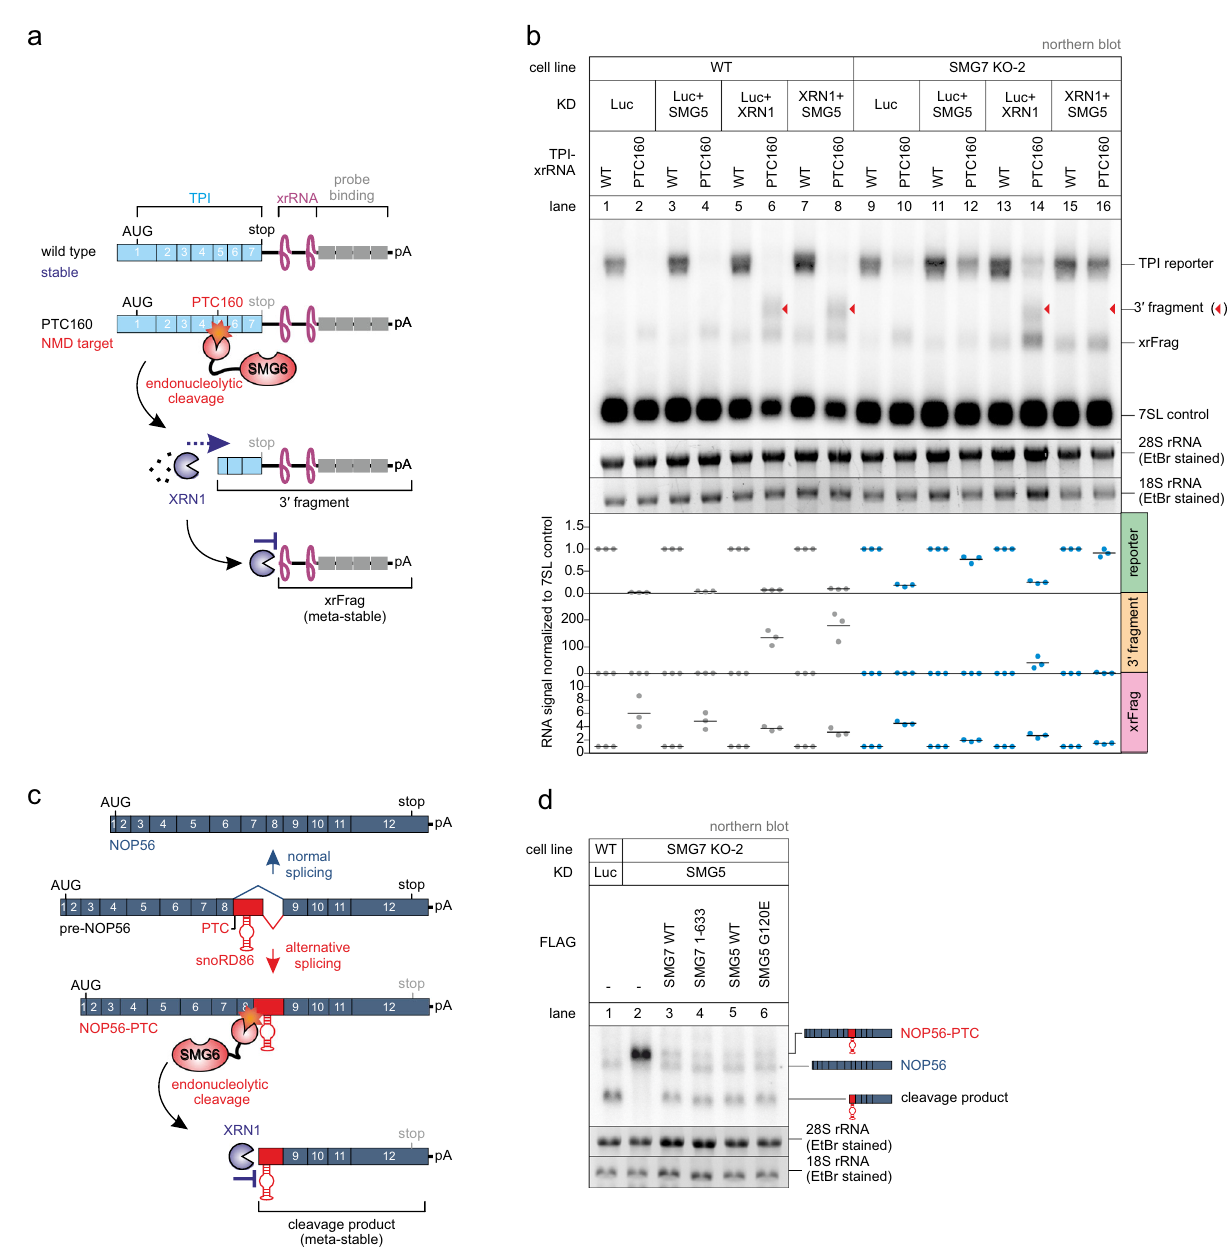
Fig. 5 SMG6 endonucleolytic cleavage is inactivated in SMG5-SMG7 depleted cells. a Schematic overview of the triosephosphate isomerase (TPI) reporter constructs and their functional elements. The PTC160-containing reporter is subjected to SMG6-mediated endonucleolytic cleavage during NMD. The resulting decay intermediate (3 ′ fragment) is rapidly degraded by XRN1, until the presence of an xrRNA blocks the processivity of XRN1, ultimately resulting in the accumulation of meta-stable xrFrag molecules. b Northern blot analysis of TPI reporter, 3 ′ fragments (indicated with red triangles), xrFrag, and 7SL endogenous control. Ethidium bromide-stained 28S and 18S rRNAs are shown as additional controls. Quanti fi cation results (normalized to 7SL control) are shown as data points and mean ( n = 3 biologically independent samples). c Schematic depiction of NOP56 maturation and the consequences of alternative splicing for inducing NMD. Upon inclusion of the snoRD86 sequence in the mature NOP56 mRNA by alternative splice site usage, a PTC is introduced resulting in endonucleolytic cleavage by SMG6. XRN1-mediated degradation of the decay intermediate is hindered by snoRD86, resulting in the accumulation of this meta-stable cleavage product. d Northern blot analysis of endogenous NOP56 ( n = 3 biologically independent samples). Different transcript isoforms and fragments are